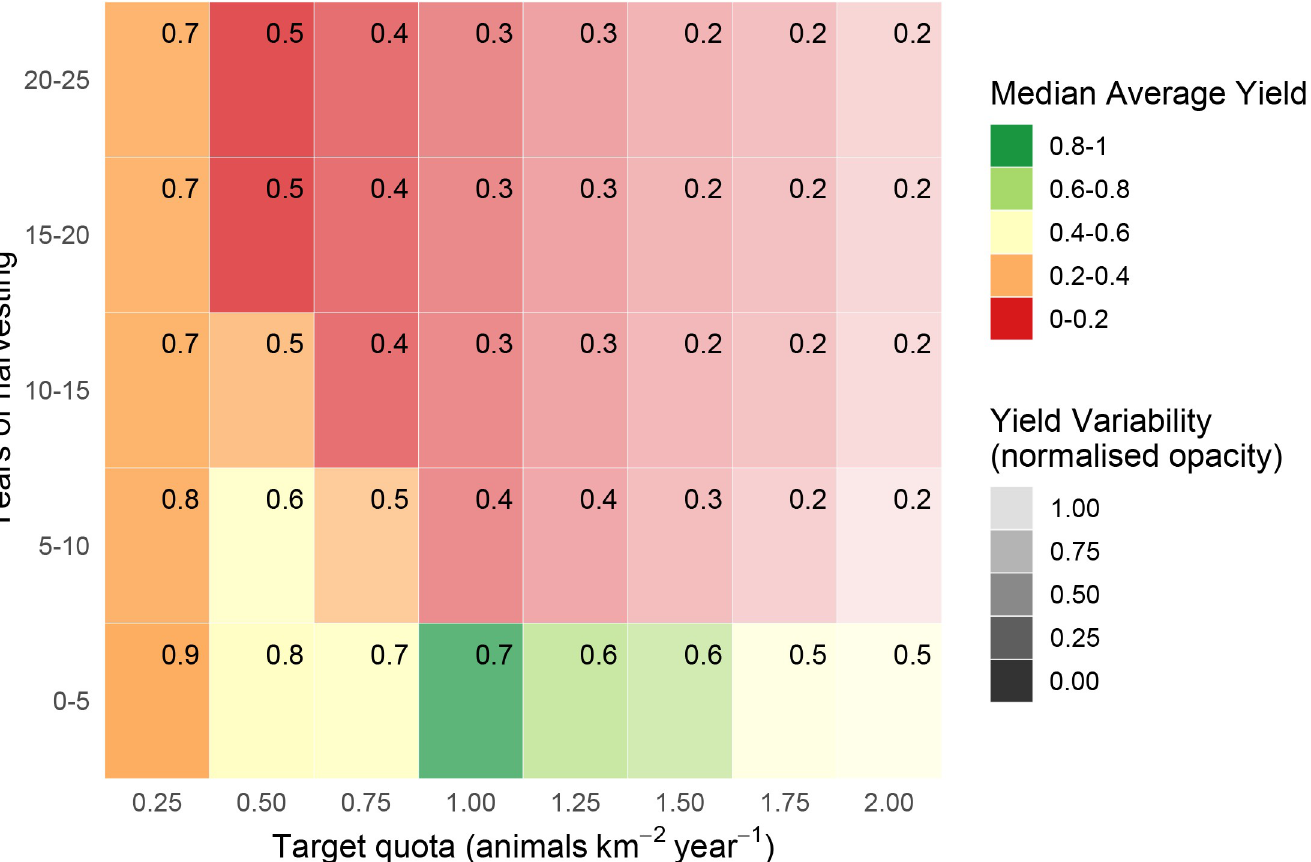
Fig 7. Estimated yields (animals km -2 year -1 ) from quota-based harvesting of bay duiker C . dorsalis . Yields are estimated over 25 years in 5-year increments, with parameter uncertainty, with corresponding survival probabilities (in top-right corner of each rectangle).